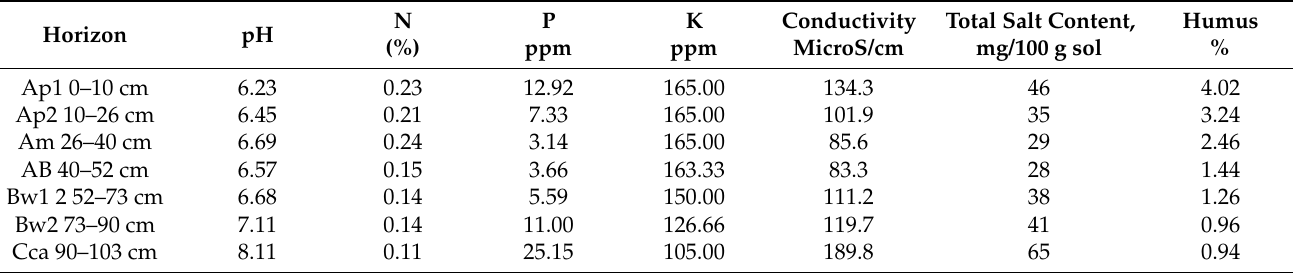
Table 3. Analytical data on the main agrochemical properties of the downstream profile of the standard plots, SCDCES—MM Perieni.